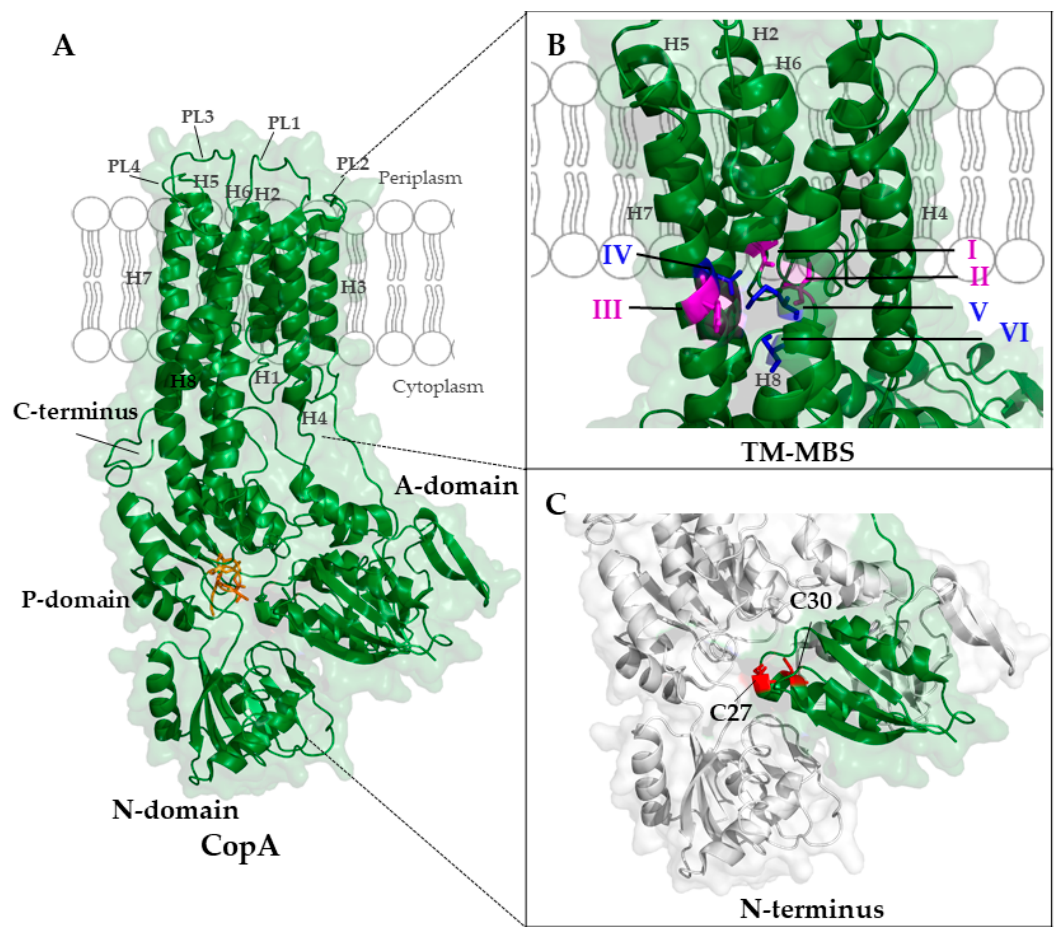
Figure 7. Cryo-electron microscopy structure of the A. fulgidus CopA (PDB 3j09) [239] . ( A ) CopA contains eight transmembrane helices (H1-H8), four periplasmic loops (PL1-PL4) and three cytoplasmic domains (actuator domain (A-domain), nucleotide-binding domain (N-domain), and phosphorylation-domain (P-domain)). The invariant DKTGT motif of the P-domain is shown in orange. ( B ) The two transmembrane-metal-binding sites (TM-MBS) of CopA have both trigonal planar coordination geometries and are depicted in magenta (TM-MBS-1; Cys380 (I) and Cys382 (II) in helix 6 and Tyr682 (III) in helix 7)) and blue (TM-MBS-2; Asn 683 (IV) in helix 7, Met711 (V) and Ser715 (VI) in helix 8), respectively. ( C ) The N-terminus of CopA shows a ferredoxin-like βαββαβ -fold (green) with a typical CxxC motif (N-MBS-2); the two cysteines are highlighted in red. Note, that in the A. fulgidus CopA structure, the N-MBS-1 is not resolved. The structure of CopA was also determined by X-ray crystallography [57] .